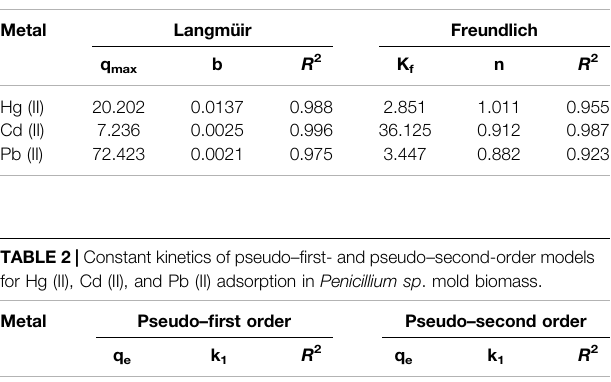
TABLE 1 | Constant adsorption isotherms in Langmüir and Freundlich models of Hg (II), Cd (II), and Pb (II) for Penicillium sp .